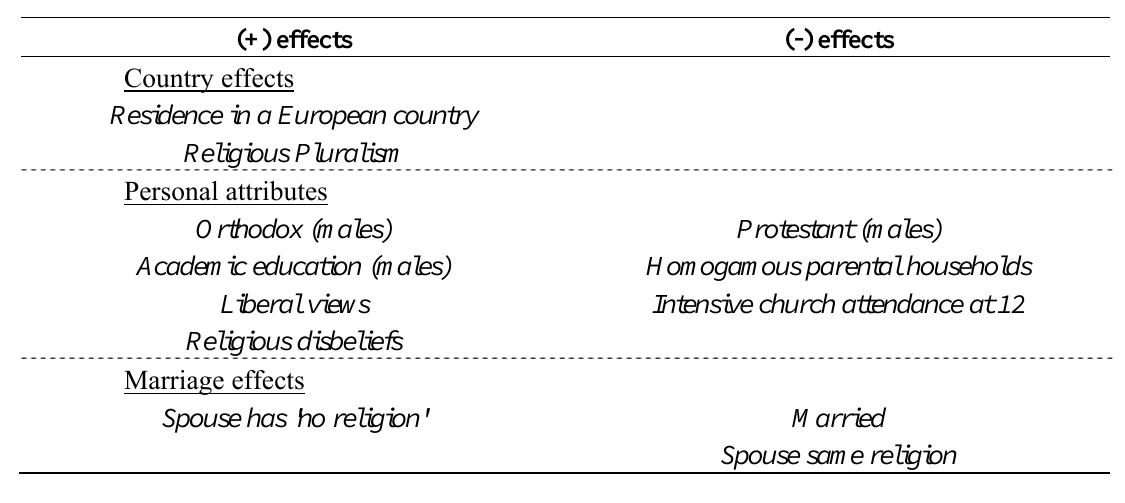
Table 3. Summary of regression results: effects of explanatory variables on the probability to convert